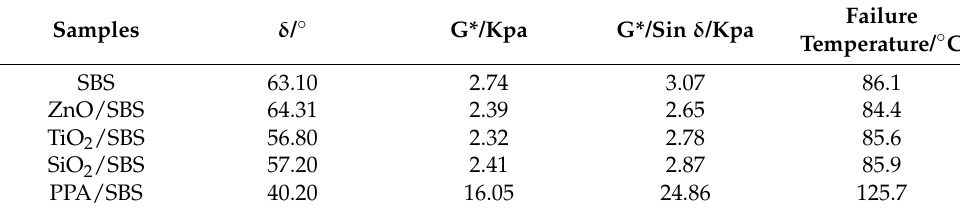
Table 1. Rheological properties of all asphalt samples in RFTO aging